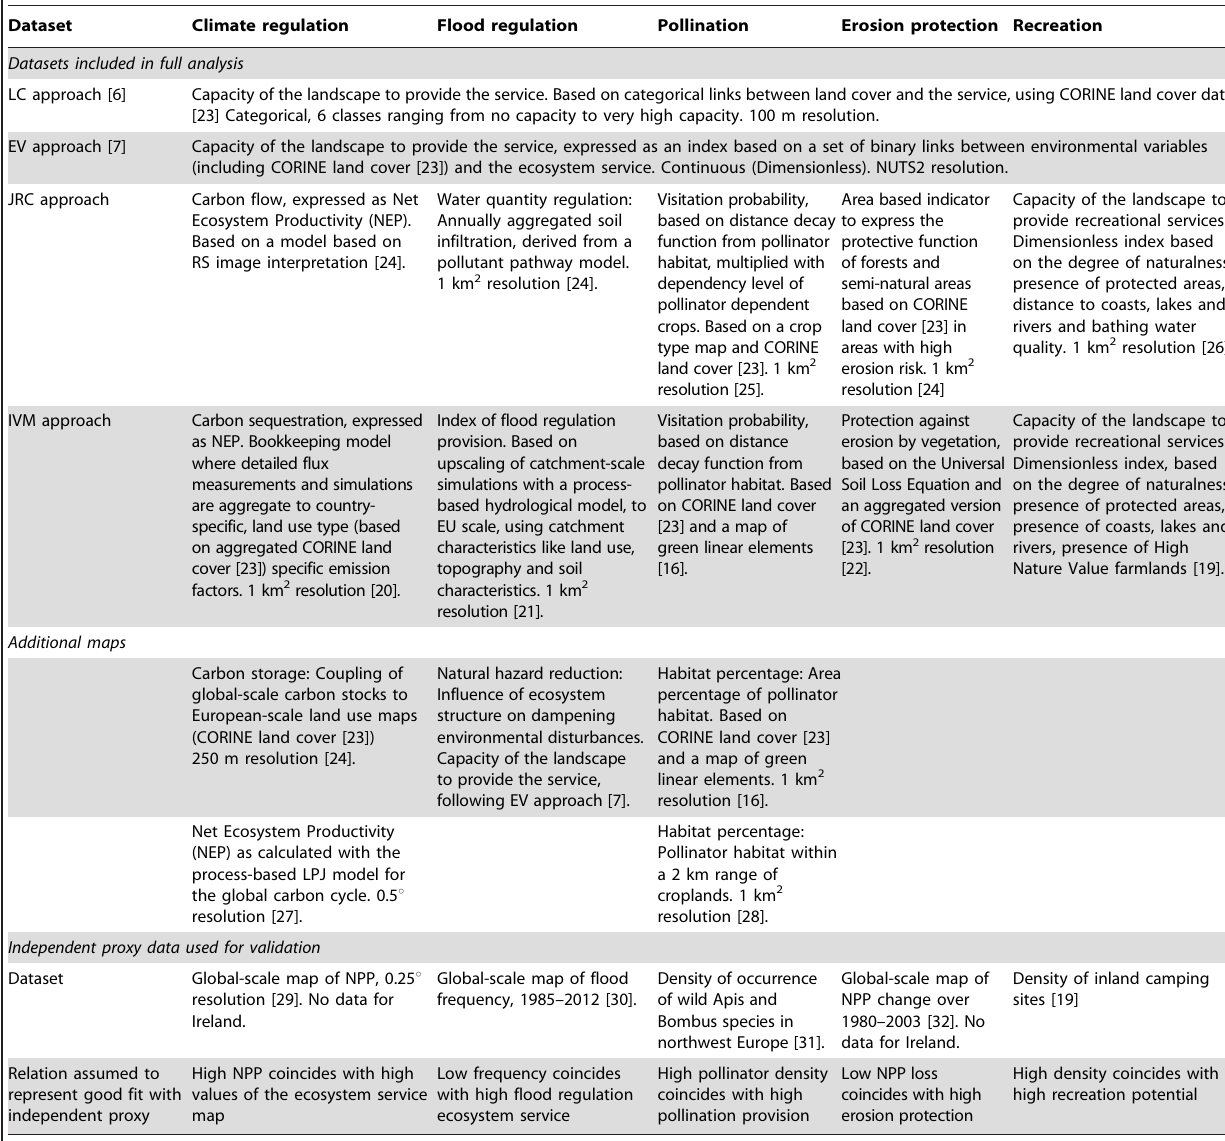
Table 1. Overview of the ecosystem service datasets analysed in this study.